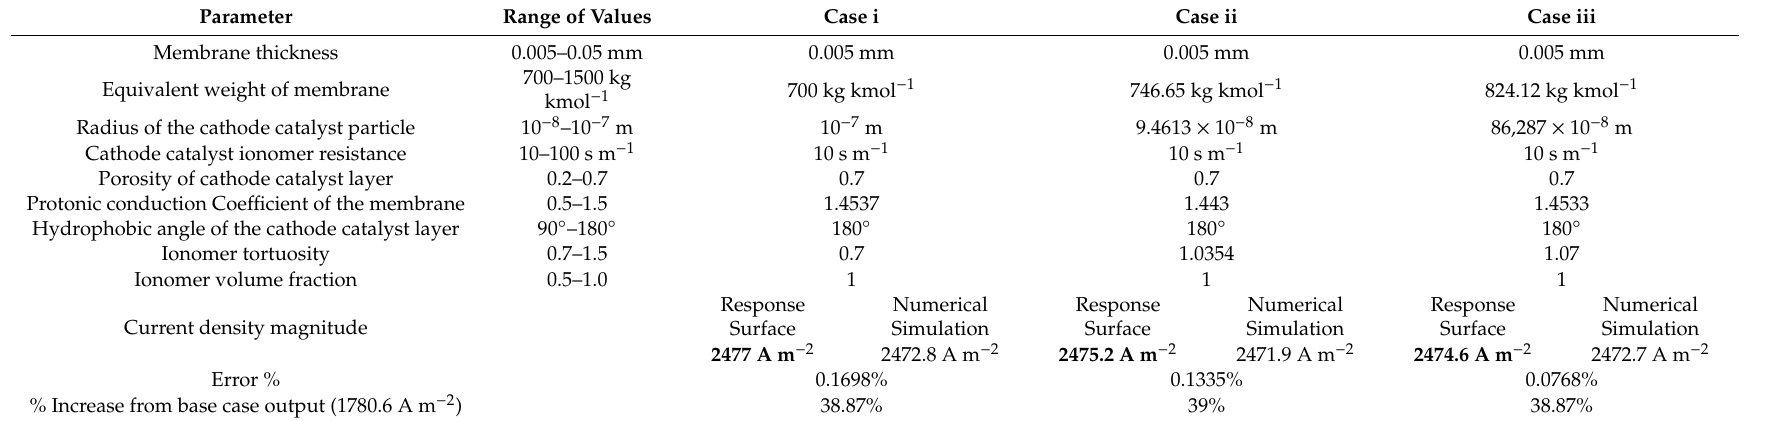
Table 5. Optimization result for three candidate points at 0.8 V.